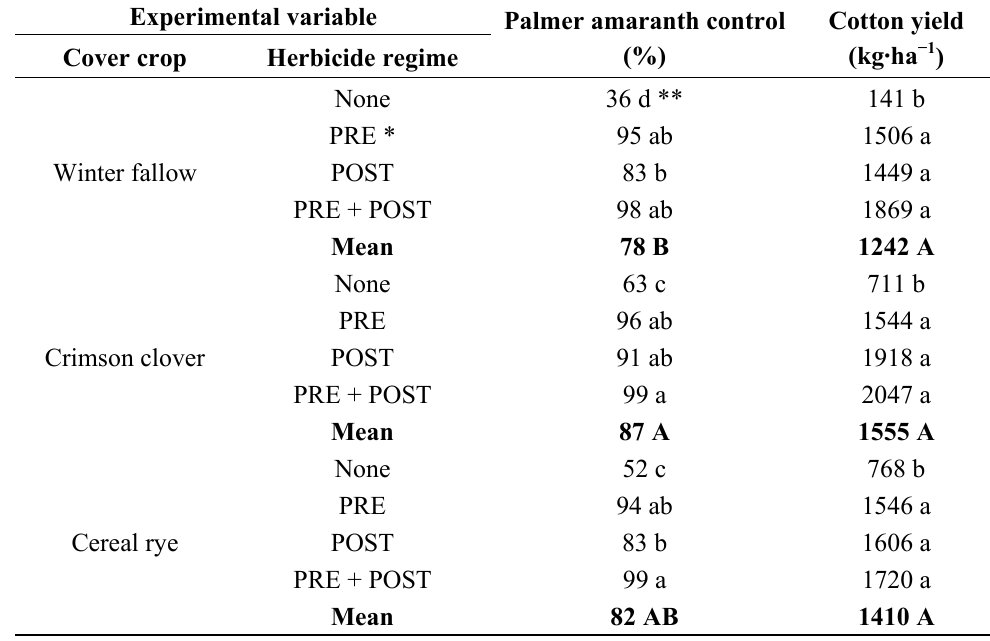
Table 6. Cover crop by herbicide regime interaction effect on Palmer amaranth control at 6 WAP * with soil-inversion and three production years’ data combined.